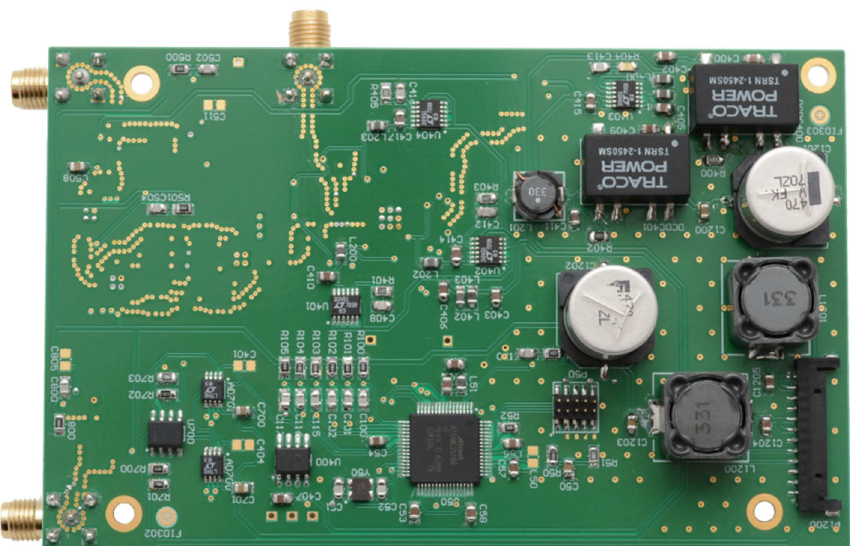
Figure 5. PCB of the new readout electronics (photo, top view) including all components required for power supply, control, and data acquisition.